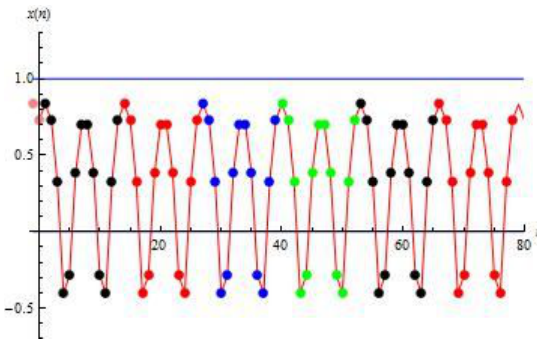
Figure 12. Period 13 for α = 0.5, t( − 1) = 0.8334938164207883‘, t(0) = 0.7294074106139652‘ (see Table